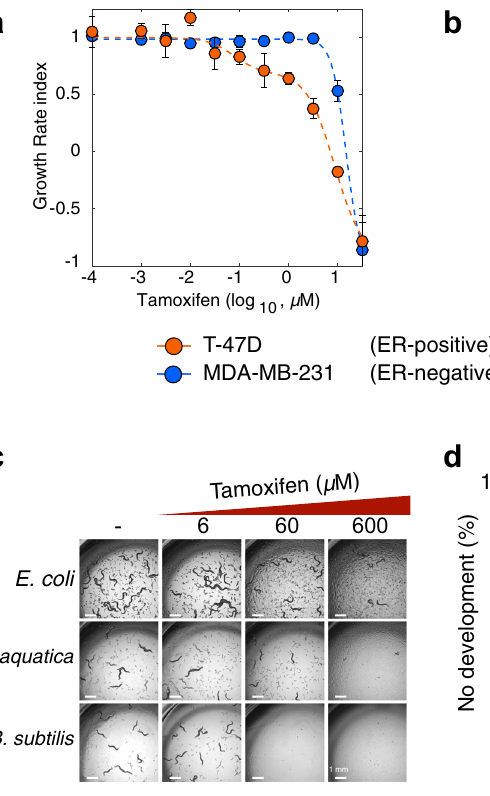
ofoneoutofthreeindependentexperiments. d Dose-responsecurves(DRCs)of C. elegans supplemented with increasing doses of tamoxifen, fed E. coli , C. aquatica , and B. subtilis . Data were represented as mean±SEM of three independent biolo- gicalreplicates. Statistical analysis ofDRCs wasconductedby performing two-way ANOVAfollowedbyaDunnettmulti-comparisontestusingthe E.coli conditionasa control on GraphPad Prism (v9). Adjusted p values <0.0001 ( C. aquatica and B. subtilis ). Source data are provided as a Source Data fi